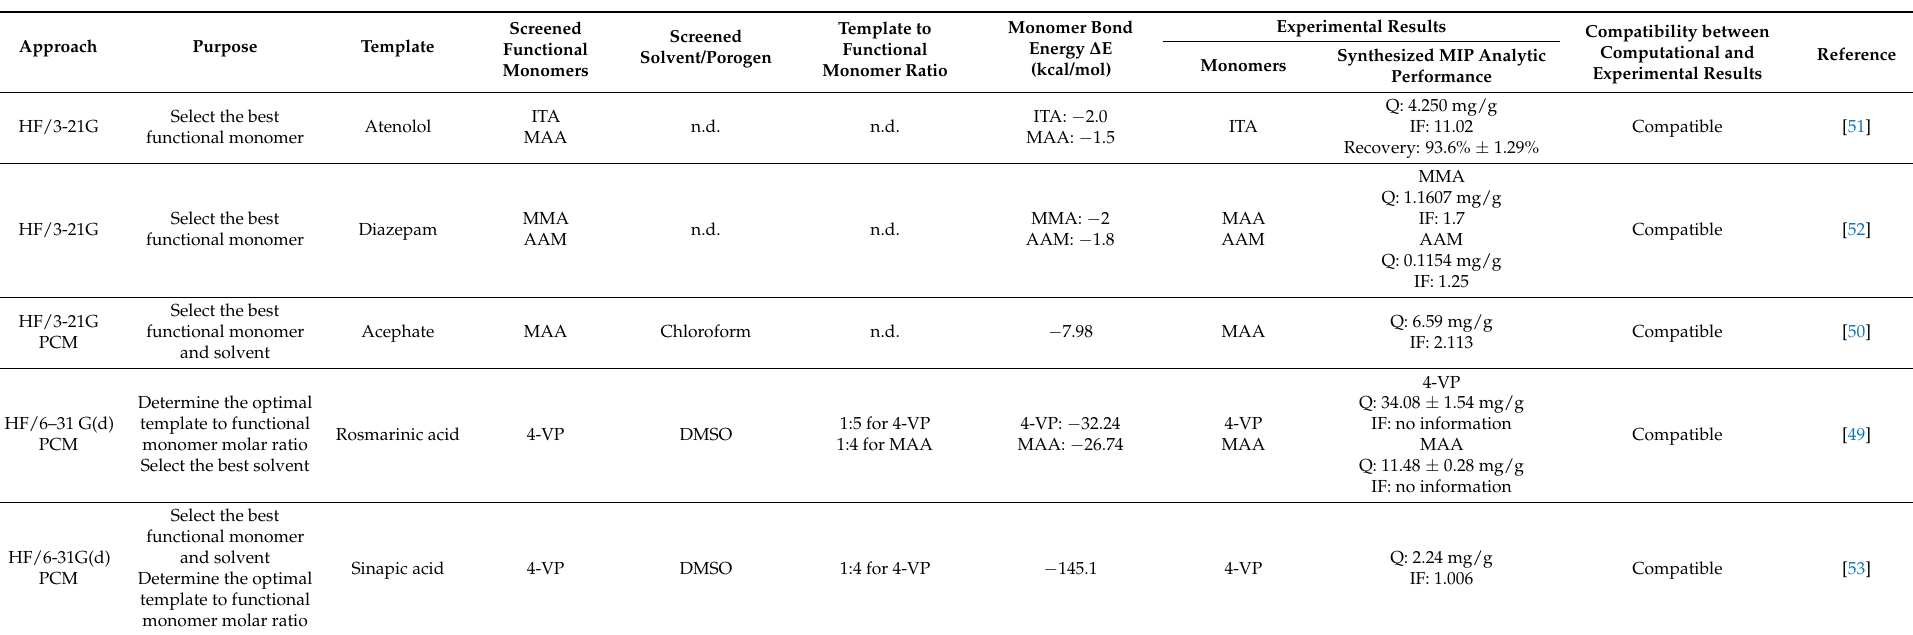
Table 2. Molecularly imprinted polymer (MIP) design using ab initio methods.